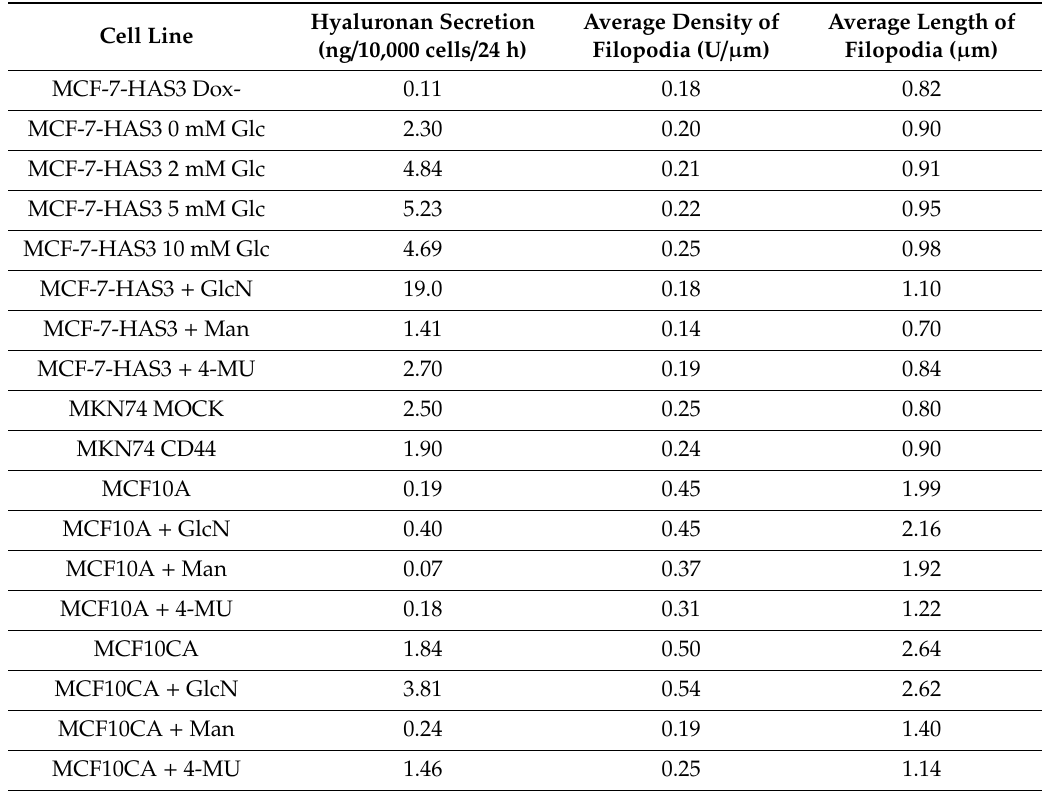
Table 1. Hyaluronan secretion levels and average length and density of filopodia in di ff erent cell lines producing various levels of hyaluronan endogenously, or via di ff erent